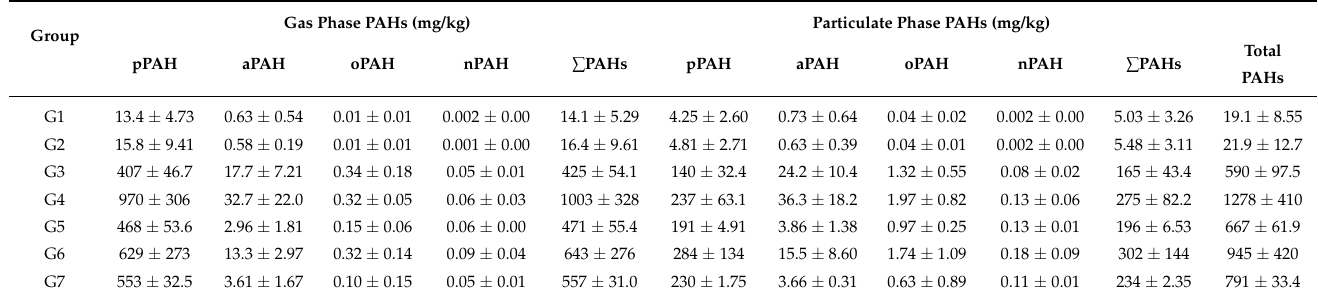
Table 1. Summary of the EF pPAH , EF aPAH , EF oPAH , and EF nPAH for the seven fuel–stove combustions (mean ± standard